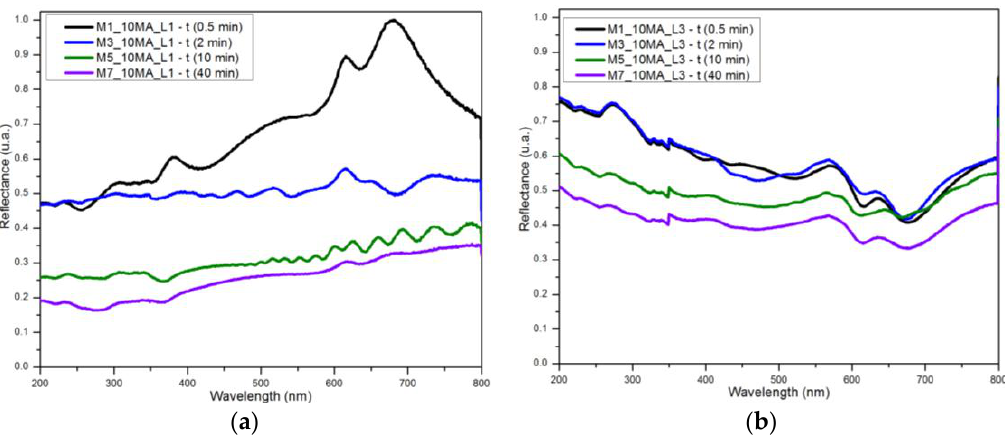
Figure 5. Reflectance spectra of PSi layers etched with 10 mA for different anodizing times ( a ) without MWCNTs and ( b ) with